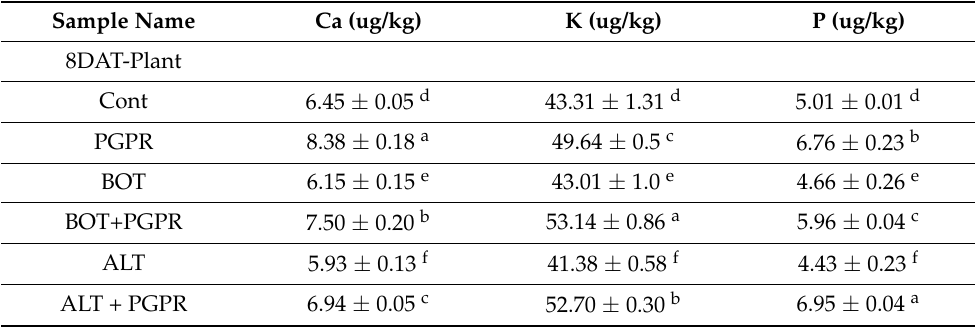
Table 4. Nutrient accumulation in pepper plants grown under biotic stress and control conditions treated with or without plant growth-promoting